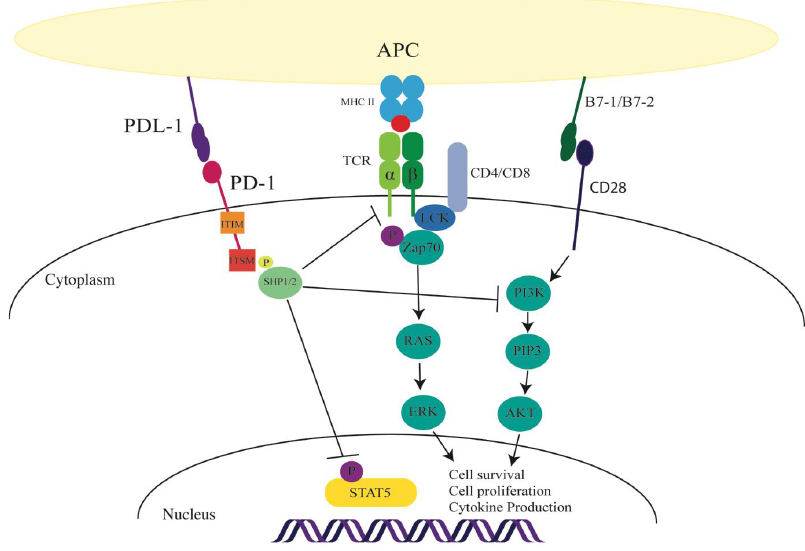
Figure 1. Consequence of programmed cell death-1 (PD-1) activation in immune cells. On engagement of the PD-1 receptor (either through programmed death ligand (PDL) -1 or 2), the PD-1 receptor recruits Sc homology region 2 domain-containing phosphatase (SHP)1 / 2 to the immunoreceptor tyrosine-based switch motif (ITSM) cytoplasmic tail. PD-1 signaling can inhibit the T cell receptor (TCR) signaling cascade. In hepatitis C virus (HCV) Tregs, the signaling can inhibit signal transducer and activator of transcription 5 (STAT5) phosphorylation. PD-1 inhibition is indicated by T bars; solid arrows indicate TCR and CD28 signaling